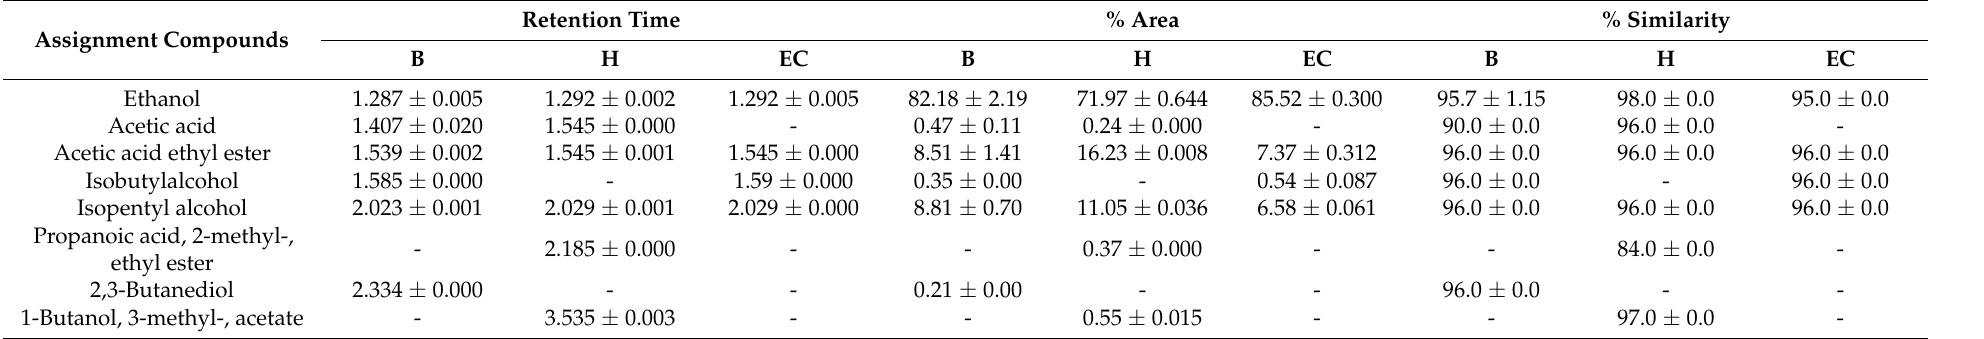
Table 2. The volatile compounds identified in plum wine samples using gas chromatography-mass spectrometry